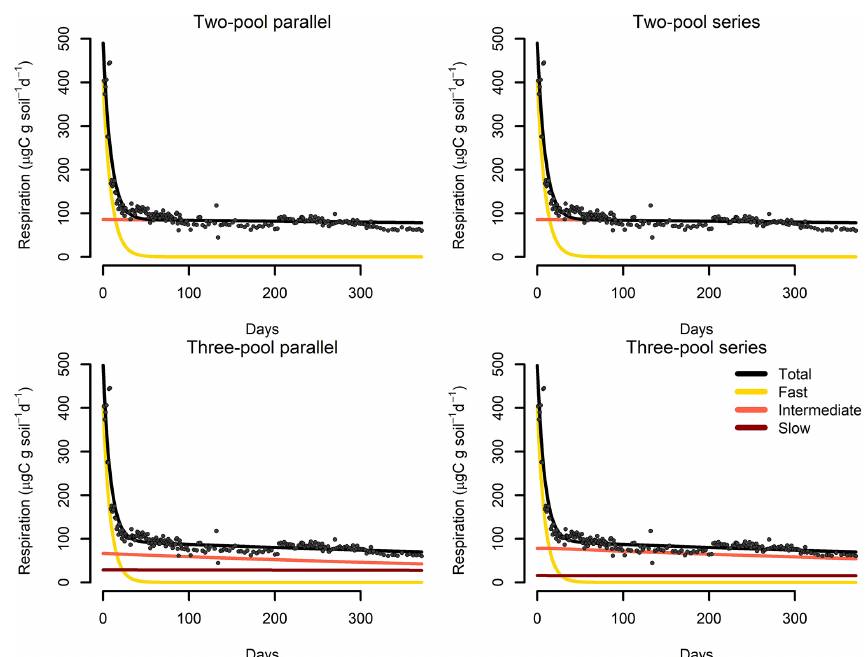
Figure 7. Results from a parameter optimization procedure to soil incubation data from a native tropical forest of Hawaii. The parallel model structures do not consider transfers of C among pools, while the series model structures transfer C sequentially from fast- to slow-cycling pools. In all cases, the models fitted the data relatively well (Table 2) and identified the relative contribution of the different pools to the overall respiration flux. Table 2. Summary statistics from the parameter optimization procedure using the database entry Crow2019a, a 371d incubation with soil from native forest in Hawaii. Number of Sum of squared Mean of squared Model